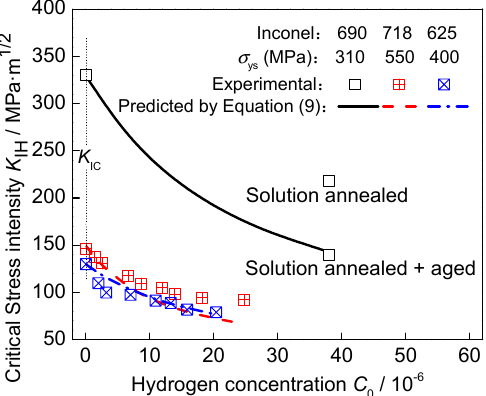
Figure 2. Comparisons between predicted values by Equation (9) and experimental values of critical stress intensity factor (CSIF) for three nickel-based alloys reproduced from [43,44] (Inconel 690, 718 and 625) as a function of initial hydrogen concentration (the values of Inconel 690 alloy in the figure were obtained by 𝐾 = (cid:4670)𝐽𝐸/(1 − 𝜈 (cid:2870) )(cid:4671) (cid:2869)/(cid:2870) , 𝐽 is the J-integral given in the reference [43], “solution annealed” means the materials were solution annealed at 1100 ° C for 4 h followed by air cooling, and “aged” means aged at 718 ° C for 10 h). In order to keep consistent with the references, 𝐶 (cid:2868) is in weight ratio in the figure, which should be transformed to atomic ratio when using Equation (9).